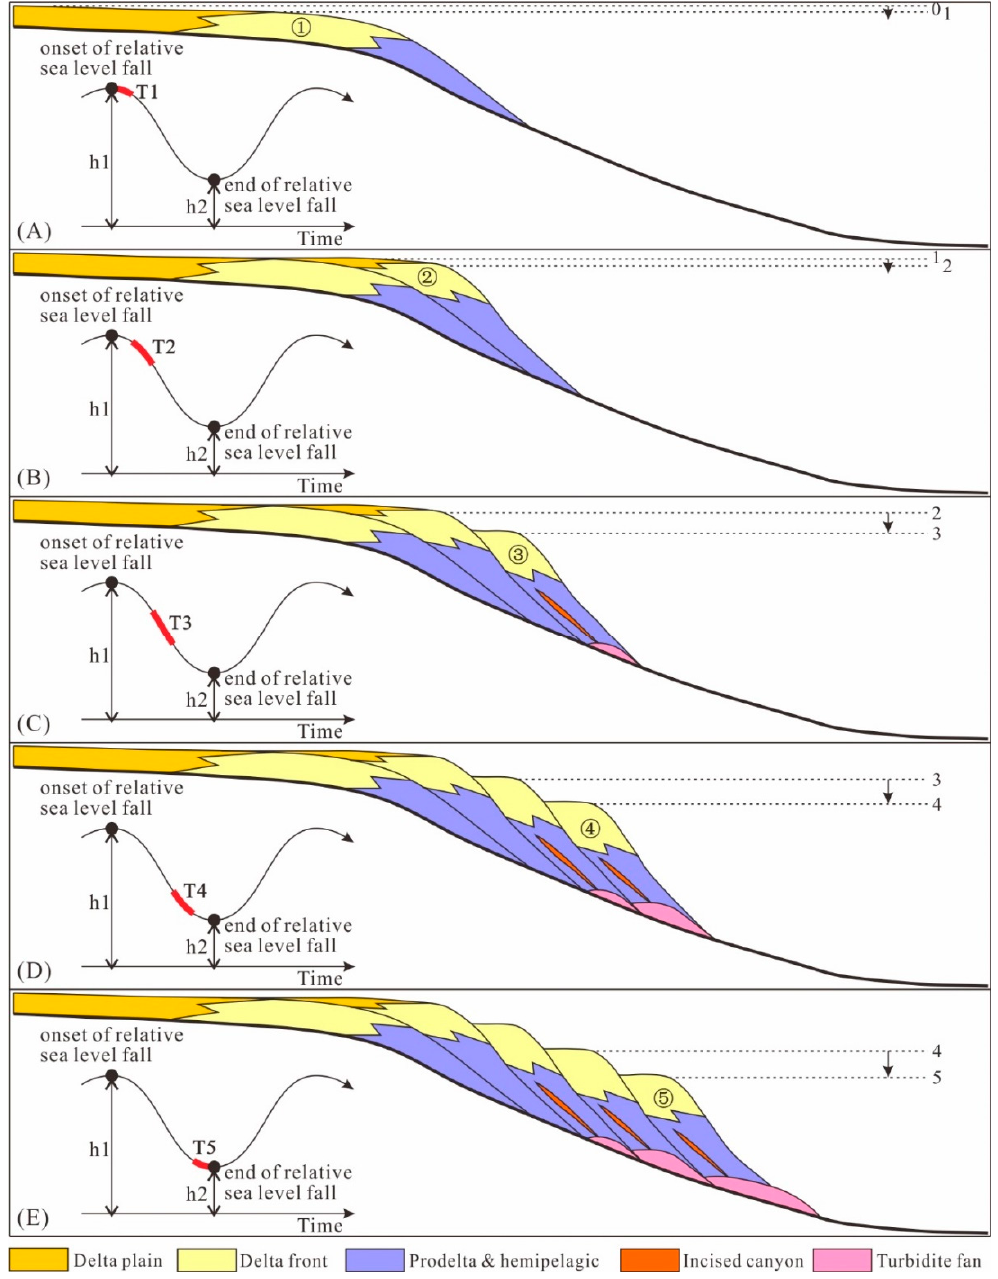
Figure 11. Sedimentary evolution model of forced regression in the Zhujiang Formation of the Pearl River Mouth Basin, northern South China Sea. ( A ) The sea level dropped from position 0 to position 1. The foreset 1 (cid:13) was deposited in T1 stage. The shelf-edge delta with delta plain, delta front, and prodelta was developed. ( B ) The sea level dropped from position 1 to position 2. The foreset 2 (cid:13) was deposited in T2 stage. The characteristics of shelf-edge delta are similar to those of the previous period. ( C ) The sea level dropped from position 2 to position 3. The foreset 3 (cid:13) was deposited in T3 stage. Only the delta front and the prodelta were developed in the shelf-edge delta. Deep-water channel and turbidite fan are developed. ( D ) The sea level dropped from position 3 to position 4. The foreset 4 (cid:13) was deposited in T4 stage. The sedimentary characteristics of this stage are similar to those of the previous stage. ( E ) The sea level dropped from position 4 to position 5. The foreset 5 (cid:13) was deposited in T5 stage. The turbidite fan developed greatly at this